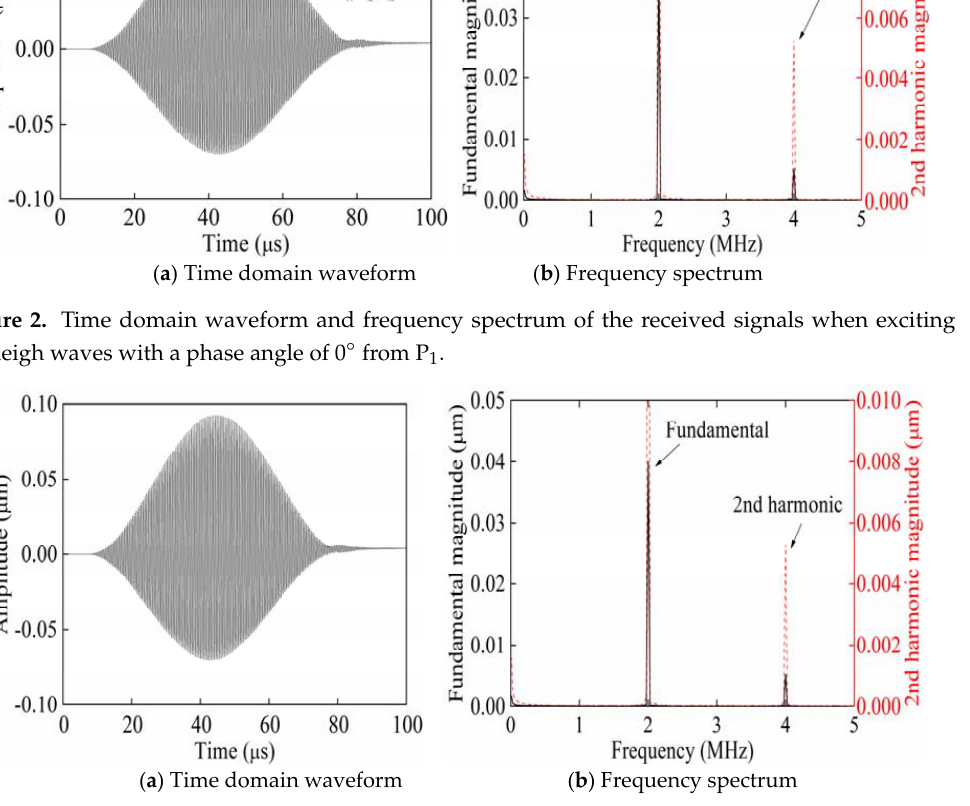
Figure 3. Time domain waveform and frequency spectrum of the received signals when exciting Rayleigh waves with a phase angle of 180 ◦ from P 2